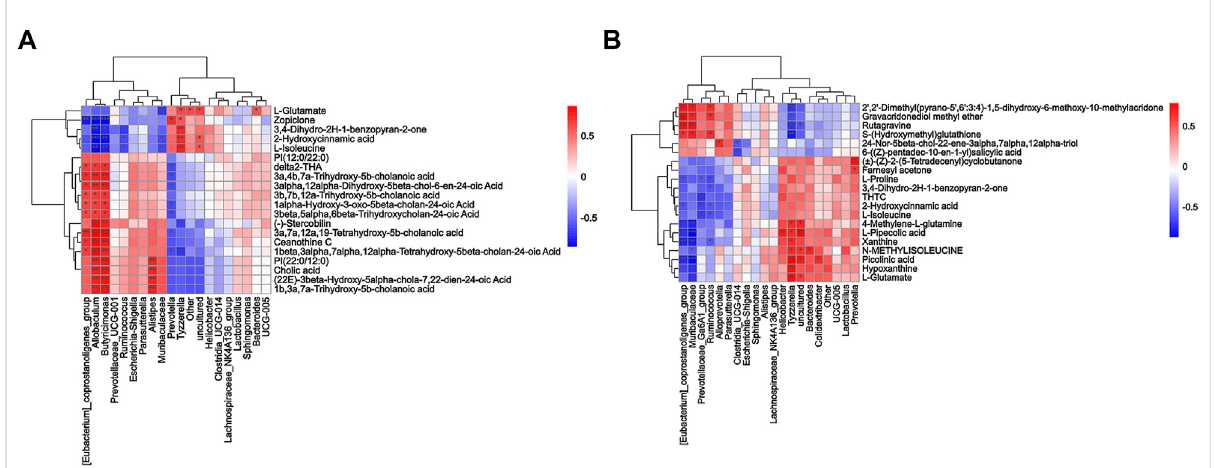
FIGURE 6 Correlation matrix network between fecal metabolites and genera of fecal microbiota. (A) Model vs. control; (B) ZYP_H vs. model. Correlation analysis of the results from the Oebiotech cloud platform (https://cloud.oebiotech.cn/task/detail/correlation-multiomics-oehw/), the color from red to blue represents the Spearman value from positive correlation to negative correlation. Asterisks represents signi fi cance of relevance: ***/**/*, p < 0.001/ p < 0.01/ p <